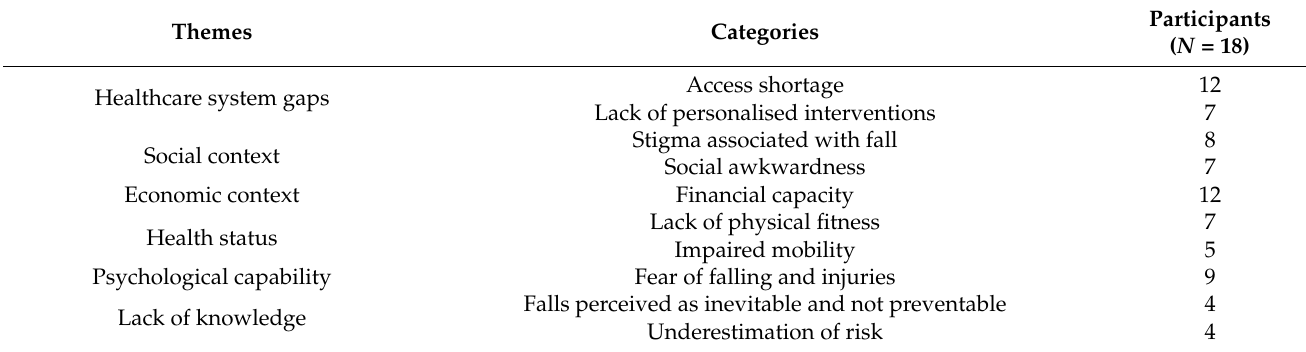
Table 1. Barriers to undertaking a fall prevention